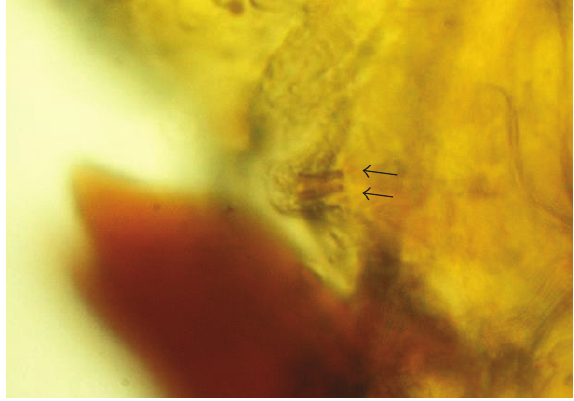
Figure 17: In profile the sternal papillae appear to have a pair of ducts (arrows) connecting to the paired sensory structures within its